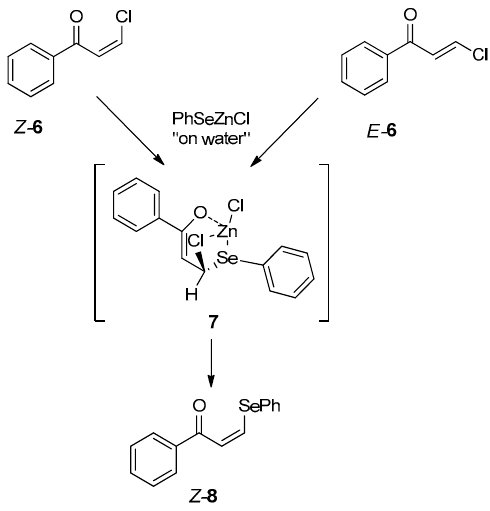
Figure 10. Vinyl substitution with a stereo-convergent mechanism.